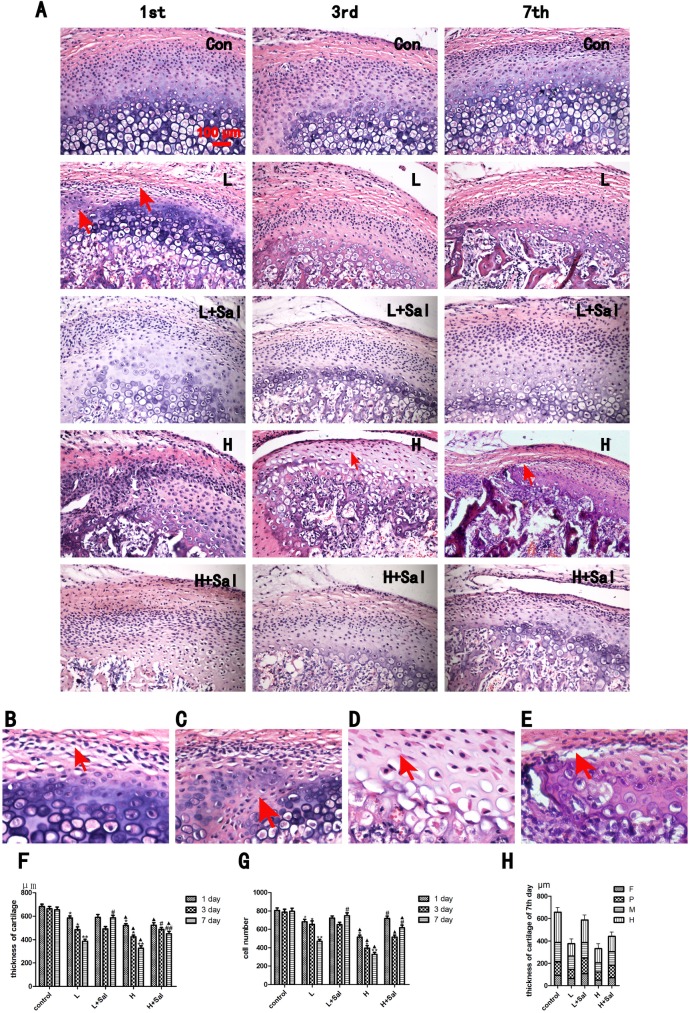
Histological examinations of cartilage under various compressive stresses and after injecting Salubrinal.(A) The thickness change in the condylar cartilage under various compressive stresses after injecting Salubrinal at days 1, 3 and 7. (B) Higher magnification in the day-1 light compressive stress subgroup. More lacunas were located in the proliferative zone. (C) Higher magnification in the day-1 light compressive stress subgroup. Chondrocytes in the proliferative zone penetrated into the hypertrophic zones. (D) Higher magnification in the day-3 heavy compressive stress subgroup. The nuclei of chondrocytes in these degraded areas were typically pyknotic and homogeneous, and the cytoplasm appeared condensed and did not fill the lacuna. (E) Higher magnification in the day-7 heavy compressive stress subgroup. The chondrocytes in the mandibular cartilage appeared disordered and disarranged. (F) Quantitative analysis of cartilage thickness. (G) Quantitative analysis of the number of cells. (H) Quantitative analysis of cartilage histological layers at day 7. Con: control group; L: light compressive stress group (40 g); H: heavy compressive stress group (80 g); L+Sal: light compressive stress group with injected Salubrinal; H+Sal: heavy compressive stress group with injected Salubrinal; F: fibrous layer; P: proliferative layer; M: mature layer; H: hypertrophic layer. Scale bars, 100 μm. (* indicates the comparison between the compressive stress groups and the control group, * p<0.05, ** p<0.01; ▲ indicates the comparison between light and heavy compressive stress groups, ▲ p<0.05, ▲▲ p<0.01; # indicates the comparison between the Sal/light compressive stress group and the Sal/heavy compressive stress group, # p<0.05, ## p<0.01).